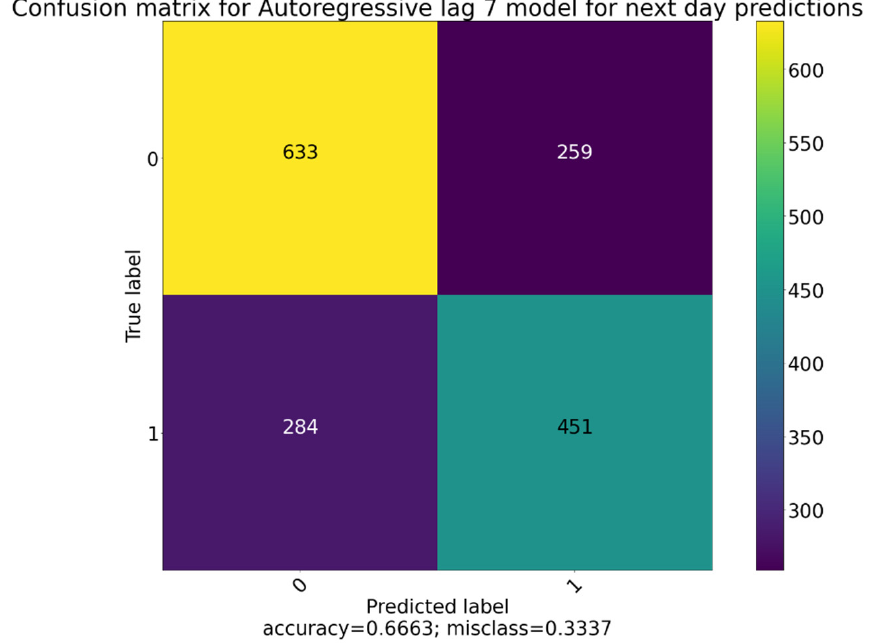
Figure 7. Confusion matrix for best performing model—Autoregressive lag 7 for next day predictions.